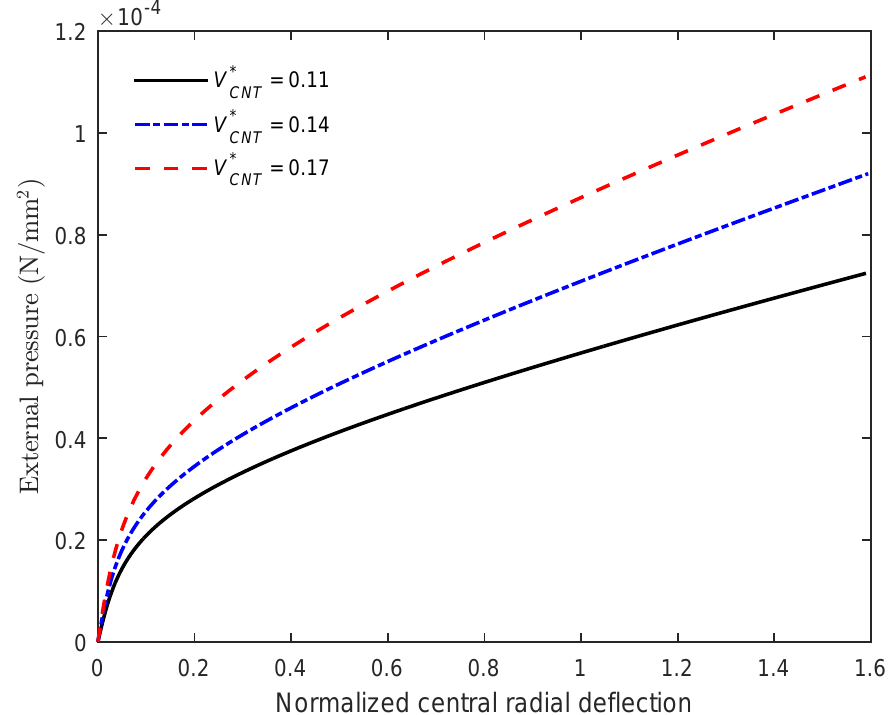
Figure 17. Normalized central radial deflections ˆ w of clamped FG-CNTRC cylinder membranes under external pressure with L / R = 4, R / h = 2200, UD distribution, various V ∗